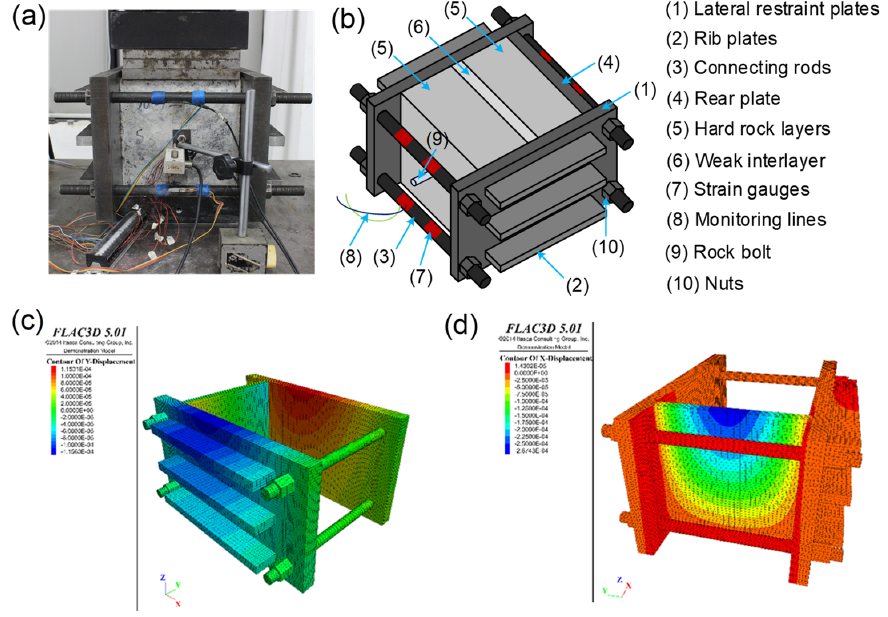
Figure 3. ( a , b ) the lateral and rear restraint sub-system; ( c ) normal displacement of lateral restraint plates; ( d ) normal displacement of rear restraint plate. displacement of rear restraint